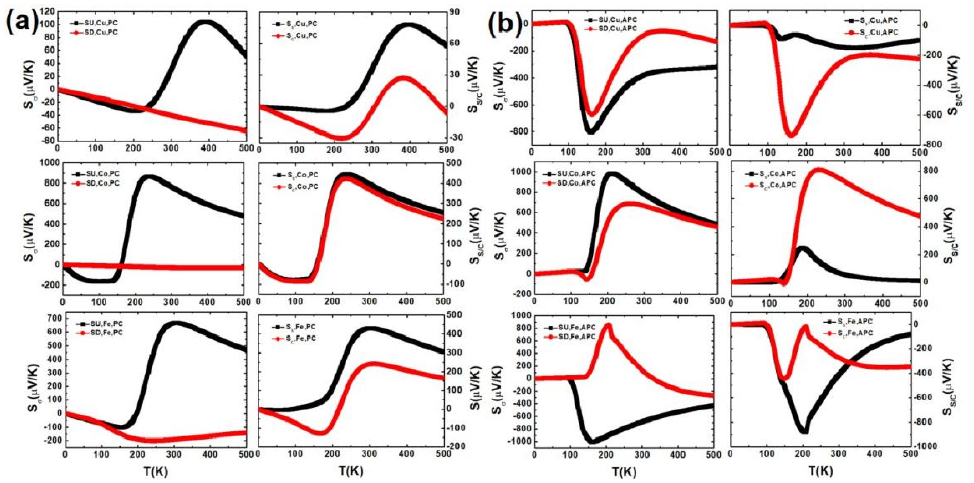
Figure 6. The spin-dependent Seebeck coefficient S σ , charge Seebeck coefficient S C and the spin Seebeck coefficient S S of CuPc, CoPc, FePc MD in a PC ( a ) and an APC ( b ) at zero bias.